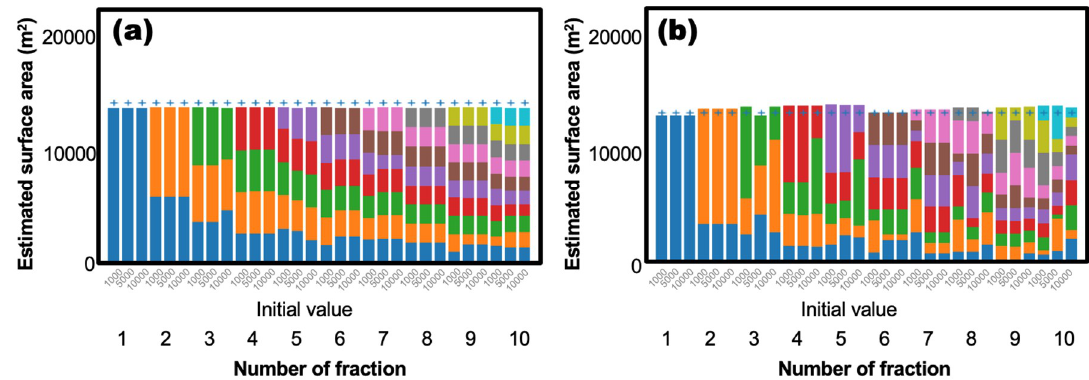
Figure 4. Estimated pore volumes for the case of ( a ) uniform fracture and ( b ) three flow paths. Exact answer is plotted as ‘+’.